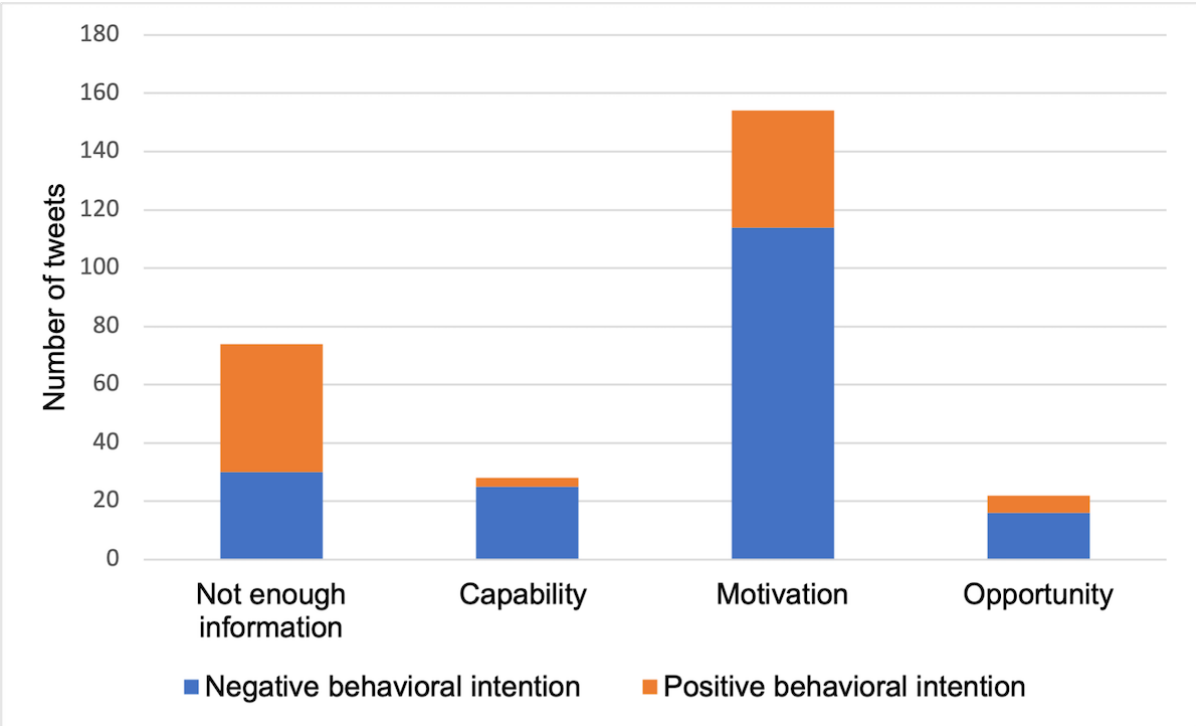
Figure 2. Numbers of tweets containing different theoretical